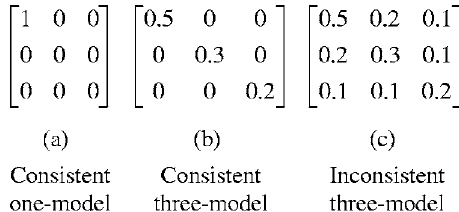
FIG. 3. Examples of the student class model density matrix: (cid:1) a (cid:2) an extreme case corresponding to the first type of class model con- dition where everyone has the same physical model (cid:1) model 1 (cid:2) , (cid:1) b (cid:2) the second type of class model condition where the class consists of three different groups of students each with a consistent physical model, and (cid:1) c (cid:2) the third type of class model condition where many students have multiple physical models and are inconsistent in us- ing